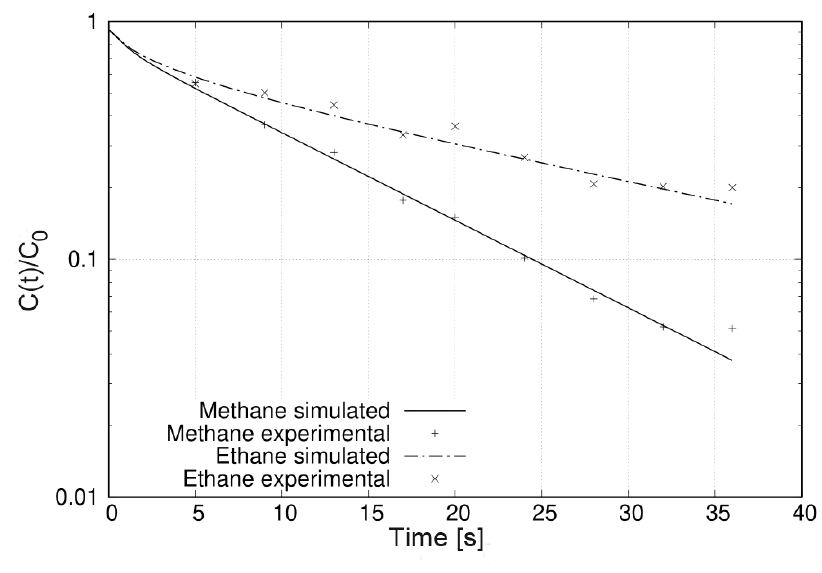
Figure 7. Bicomponent ZLC desorption curves of methane an ethane on zeolite 5A at 298K and flow rate of 5sccm. The simulated curves using Equation (1) are represented by lines while the experimental data are represented by